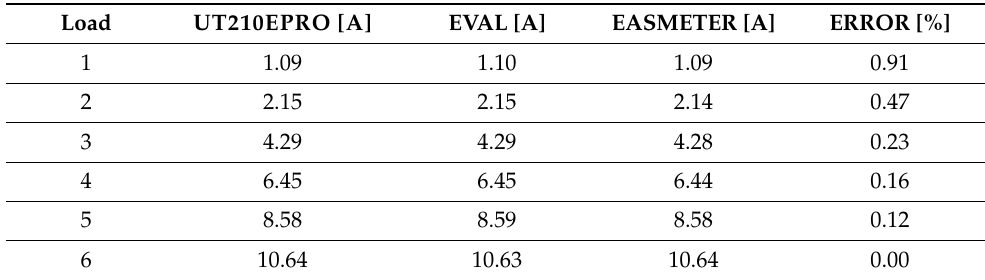
Table 4. Validation of RMS current